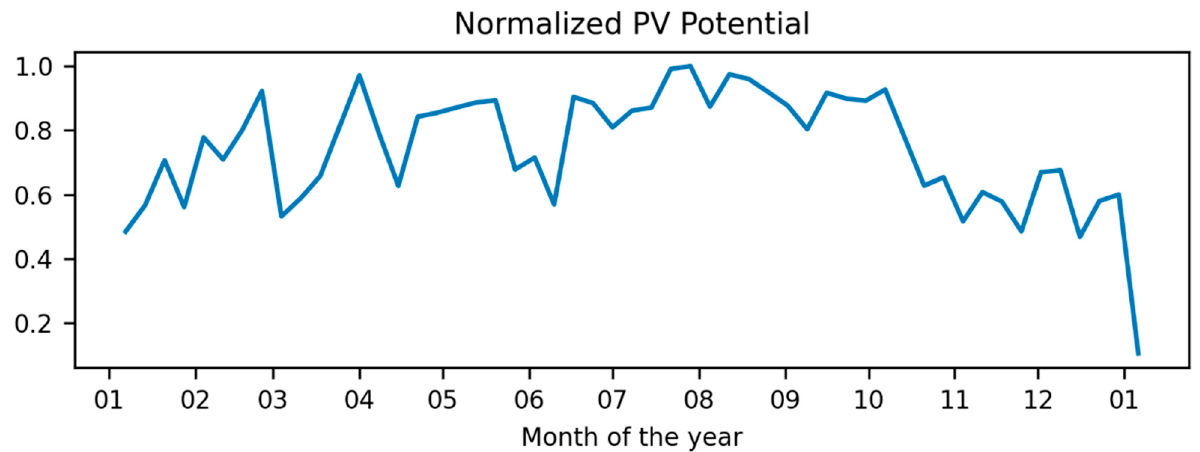
Figure 8. Normalized total weekly PV potential for Reguengos de Monsaraz for the whole year. A weekly resolution was chosen for visualization purposes. Table 2. Description of the complete dataset considered in the present work.